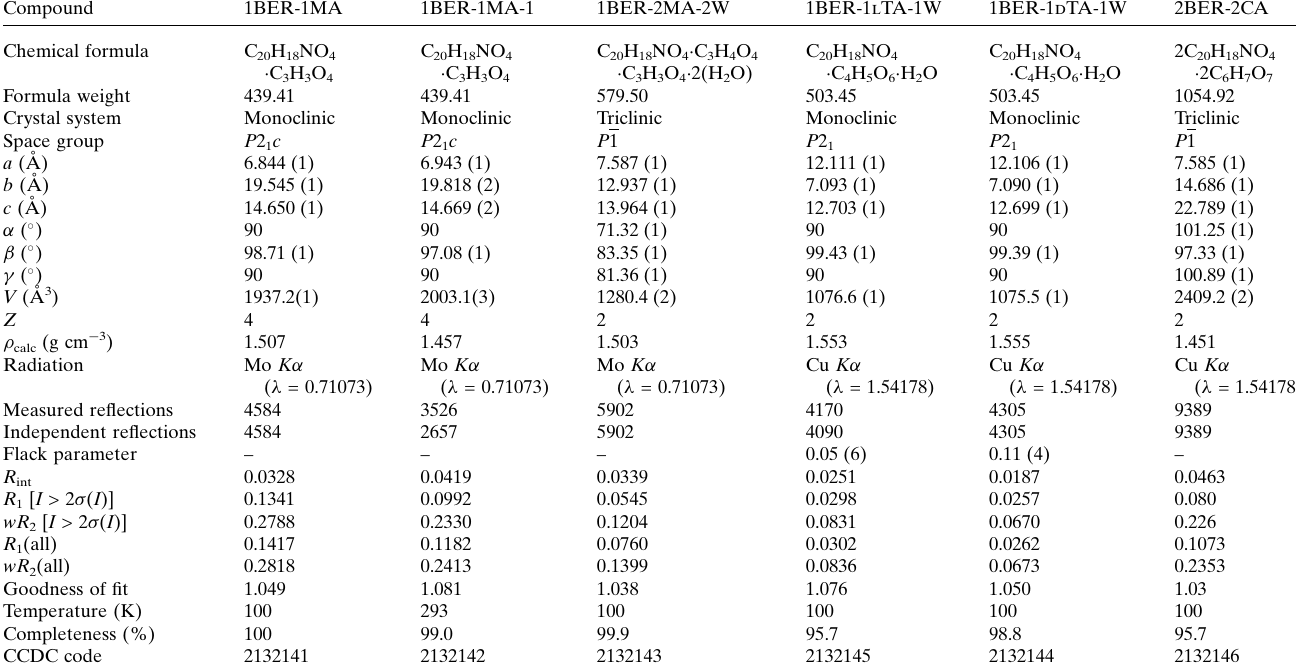
Table 1 Crystal data and structure refinement parameters for the BER solid forms obtained. Compound